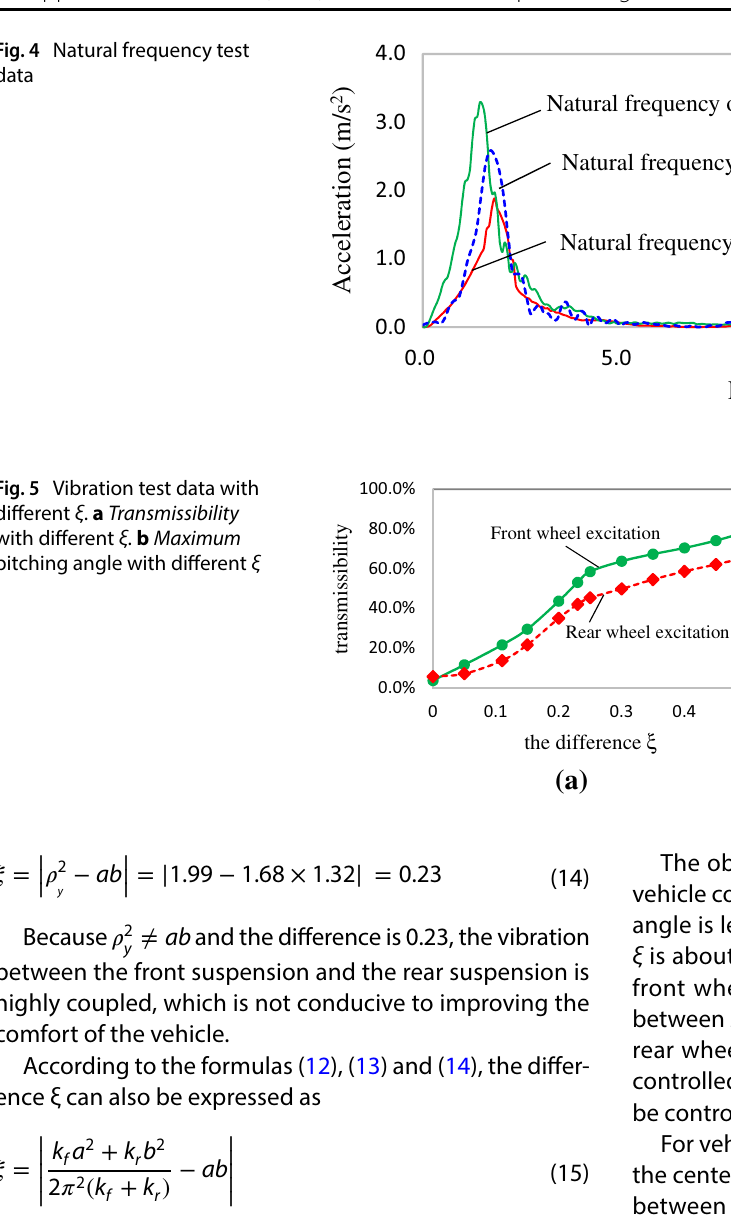
Fig. 4 Natural frequency test data